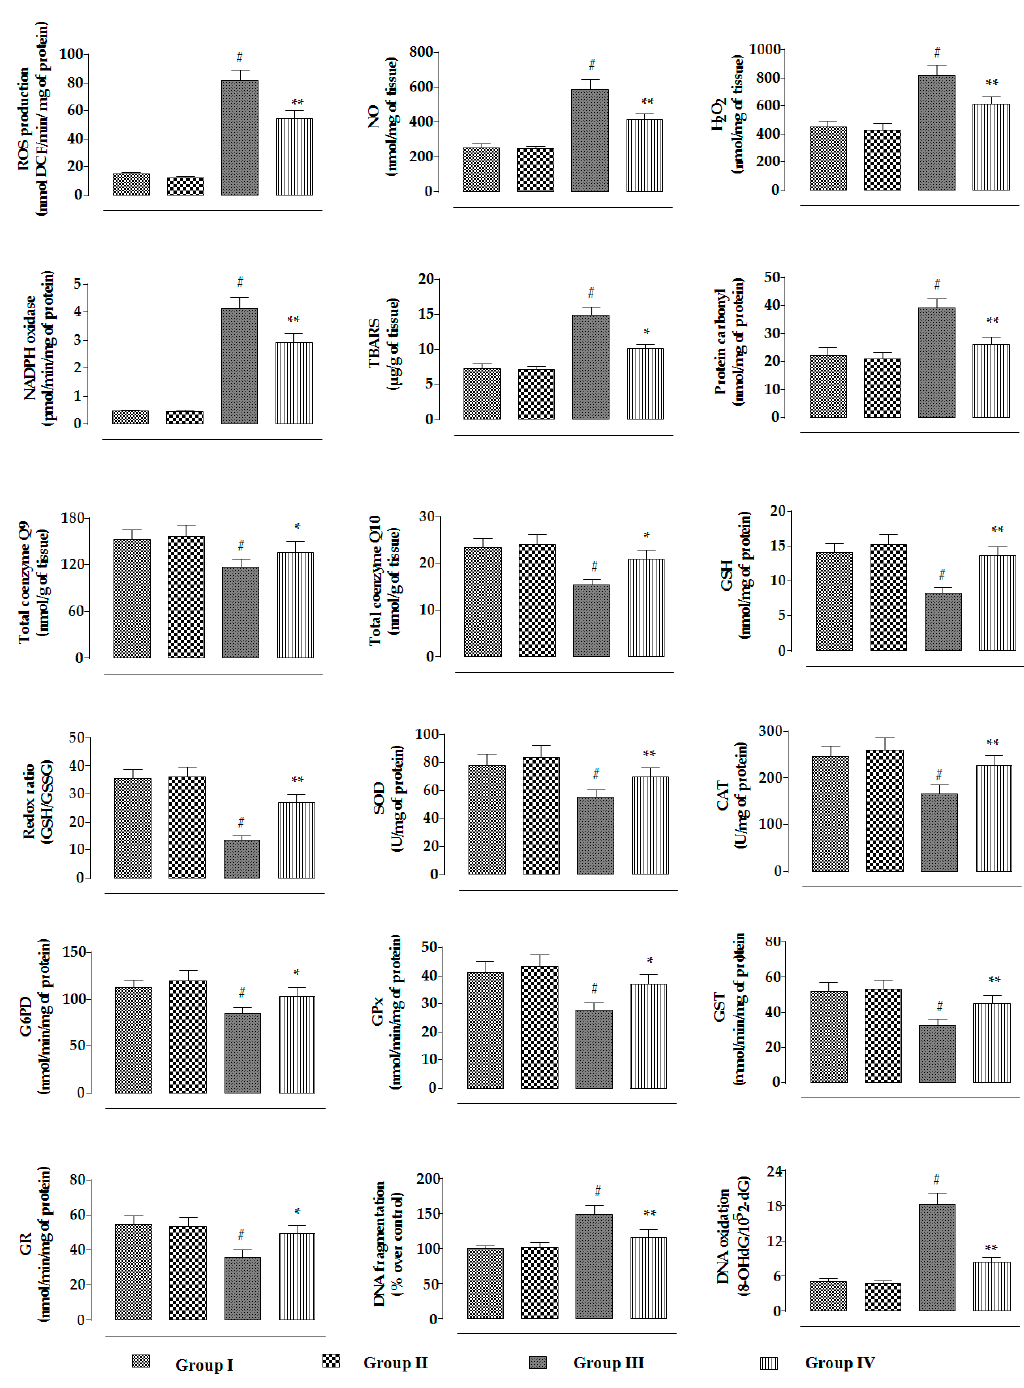
Figure 8. The e ff ects on the ROS accumulation, NO production, H 2 O 2 level, NADPH oxidase activity, extent of lipid peroxidation, extent of protein carbonylation, co-enzyme Q9 level, co-enzyme Q10 level, the levels of endogenous redox markers, degree of DNA fragmentation, and extent of DNA oxidation in the absence (CdCl 2 ) and presence of RA (CdCl 2 + RA) in vivo on mouse kidneys. Data are represented as mean ± SD, n = 6 (number of plates). # Values significantly ( p < 0.01) di ff er from normal control. * Values significantly ( p < 0.05) di ff er from CdCl 2 control. ** Values significantly ( p < 0.01) di ff er from CdCl 2 control. SOD unit, “U”, is defined as inhibition ( µ moles) of NBT reduction / min. CAT unit, “U”, is defined as H 2 O 2 consumption /